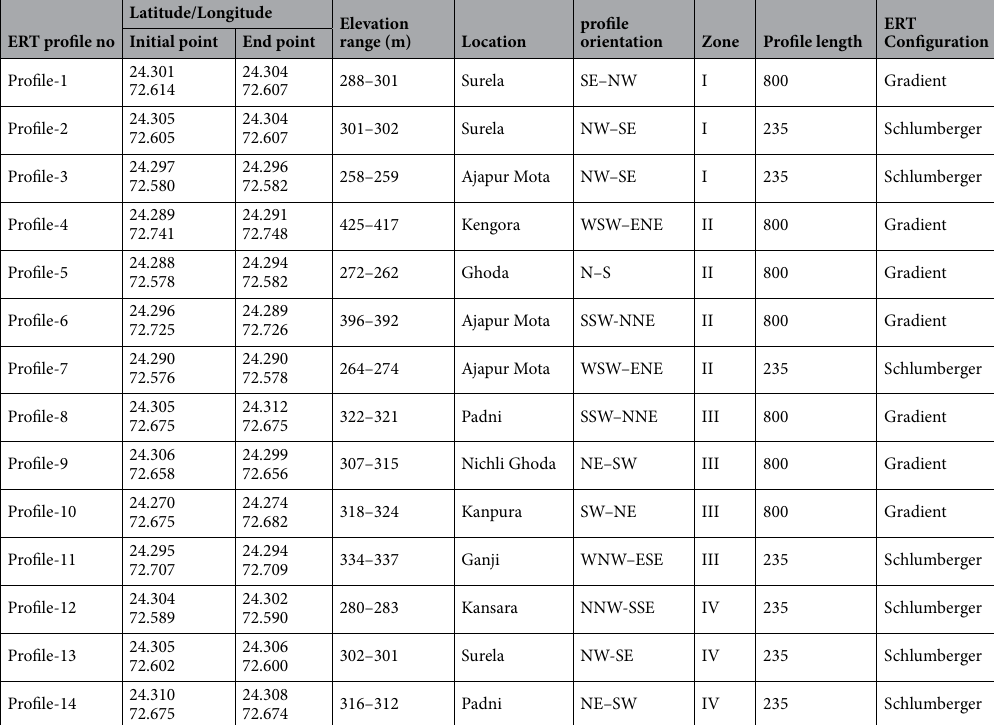
Table 1. Electrical resistivity survey locations in the study area.